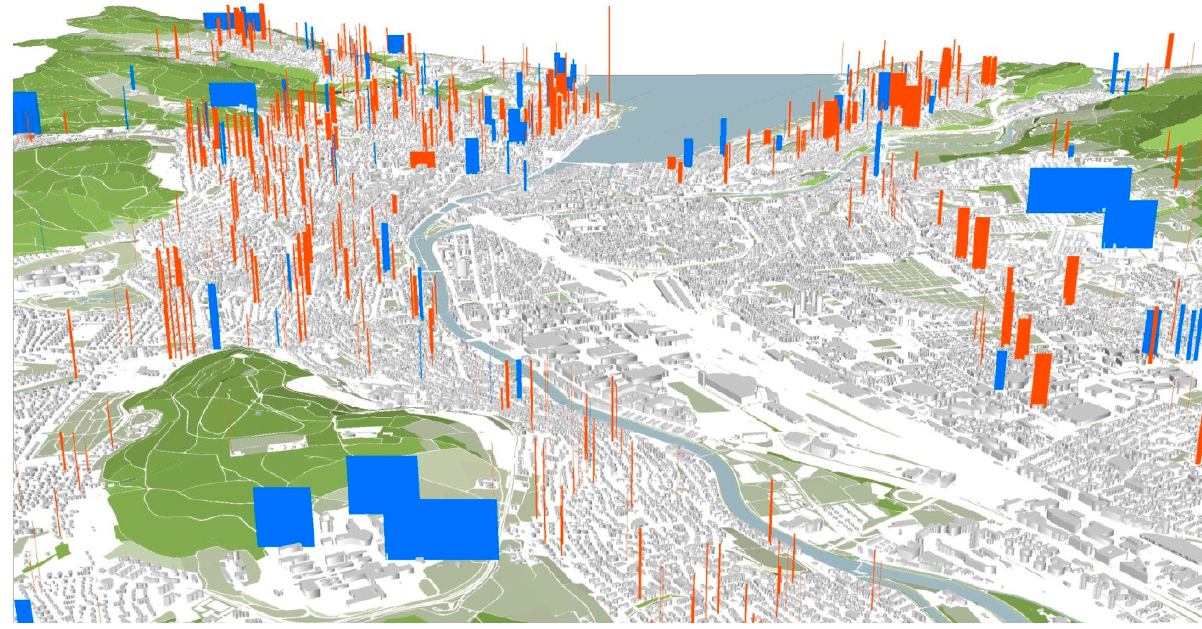
Figure 22. Geothermal heat pump installations in Zurich City. A total of 1399 GHP installations with 2681 BHEs (August 2016). Orange: heating; blue: heating and cooling. Bottom left: Largest blue symbols at Campus Hoenggerberg, ETH Zurich; details are displayed in Figure 23. Source: Zurich City Administration.